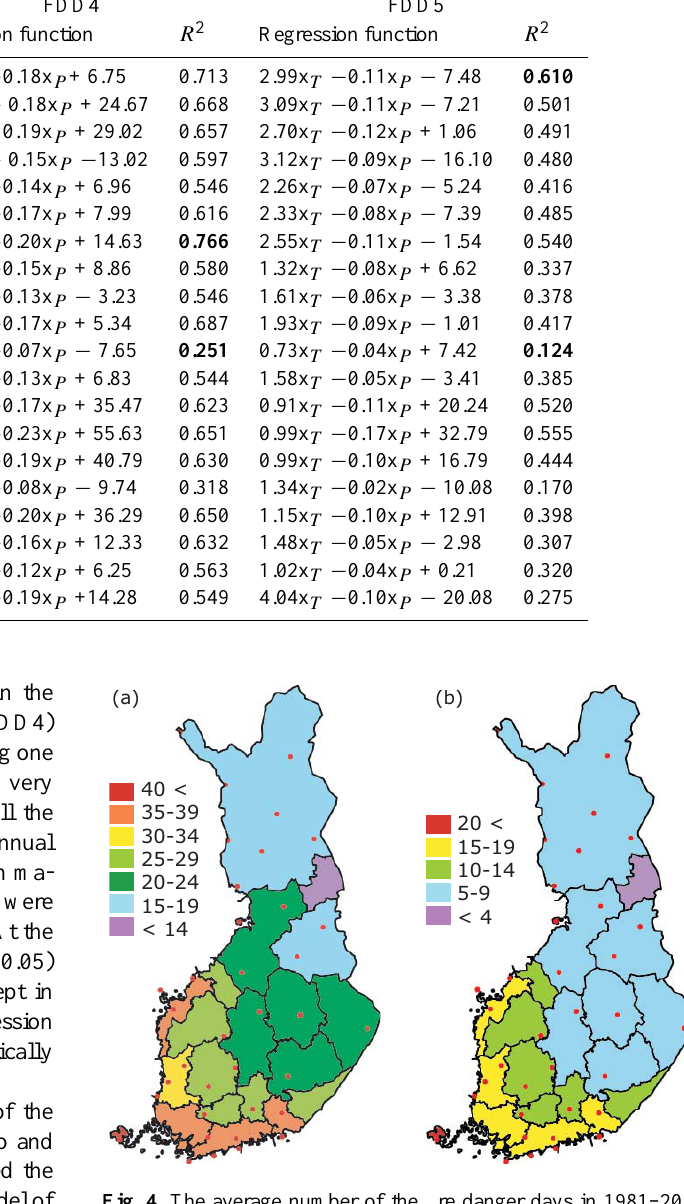
Fig. 4. The average number of the fire danger days in 1981–2010 for (a) FDD4 and (a) FDD5. The red dots mark the locations of the observation stations with FFI